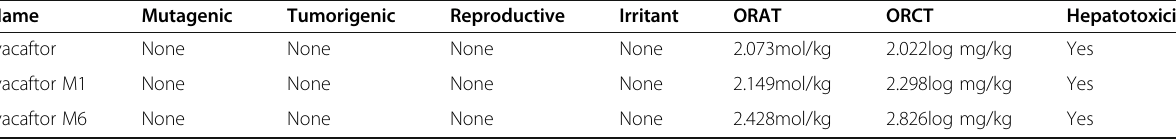
Table 19 Predicted molecular toxicity of Ivacaftor and its metabolites using data warrior Name